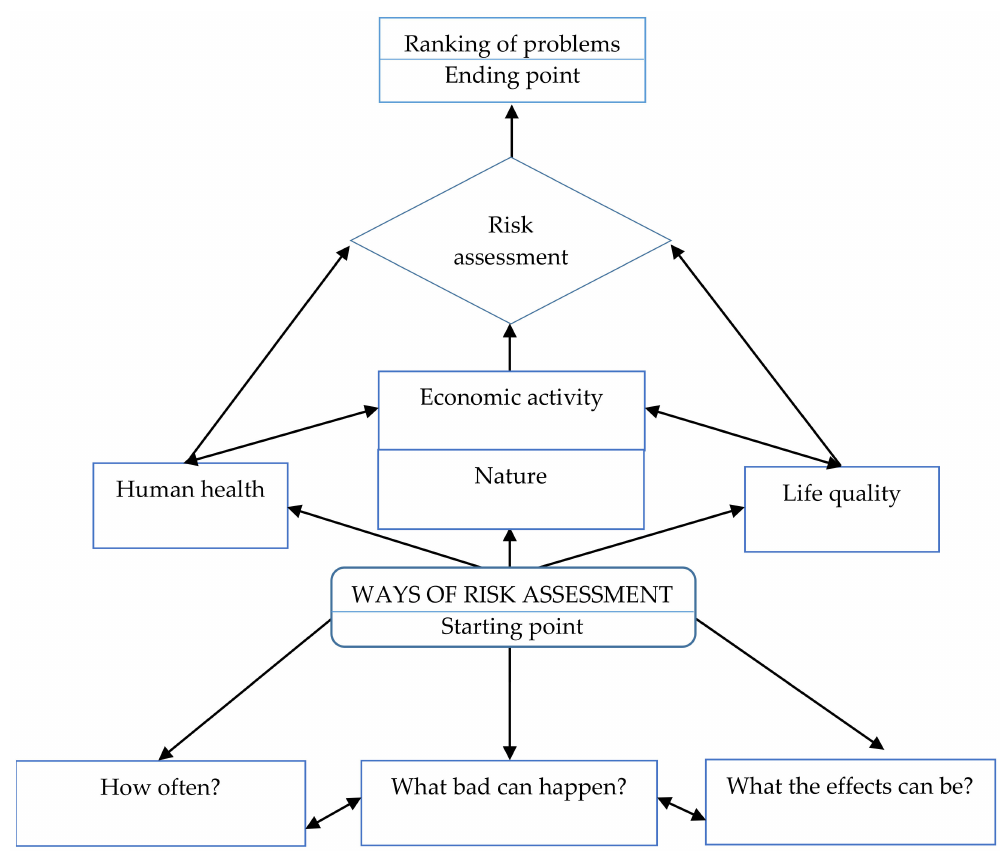
Figure 1. The concept and essence of risk on the basis of Rak